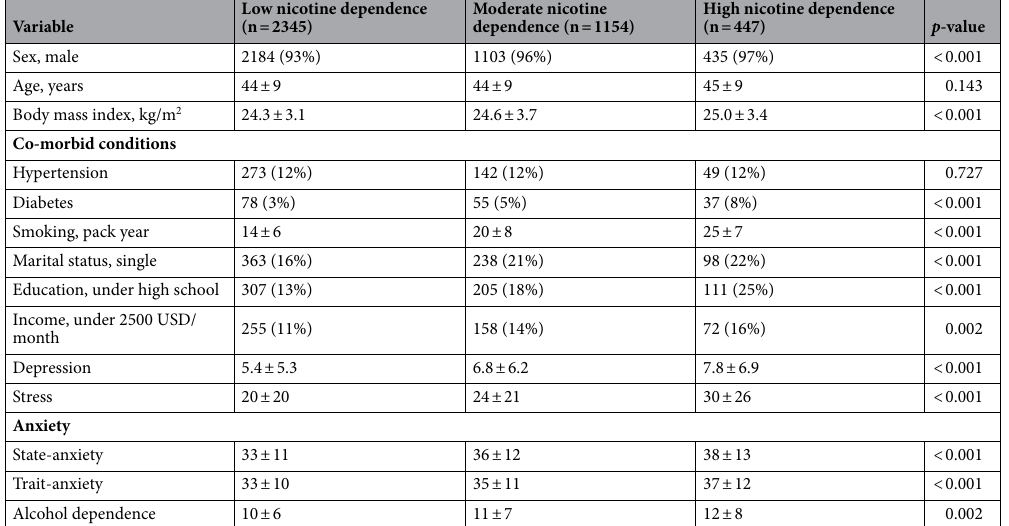
Table 3. Clinical characteristics and mental health according to nicotine dependence. Data are presented as mean with standard deviation or number (%).